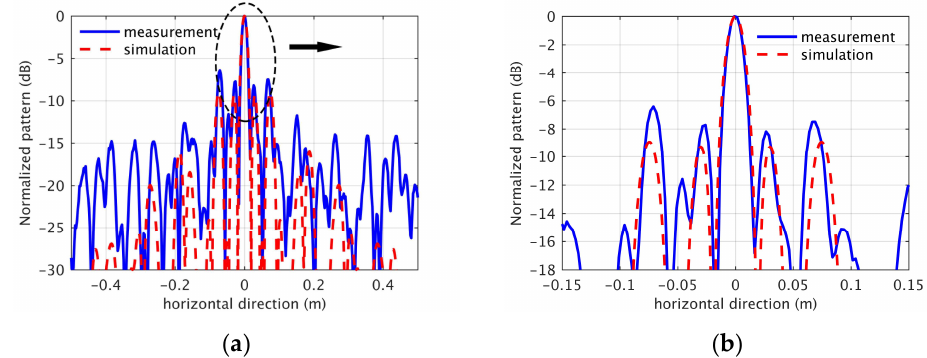
Figure 27. ( a ) The measurement and simulation results of normalized pattern at 1 m in front of the